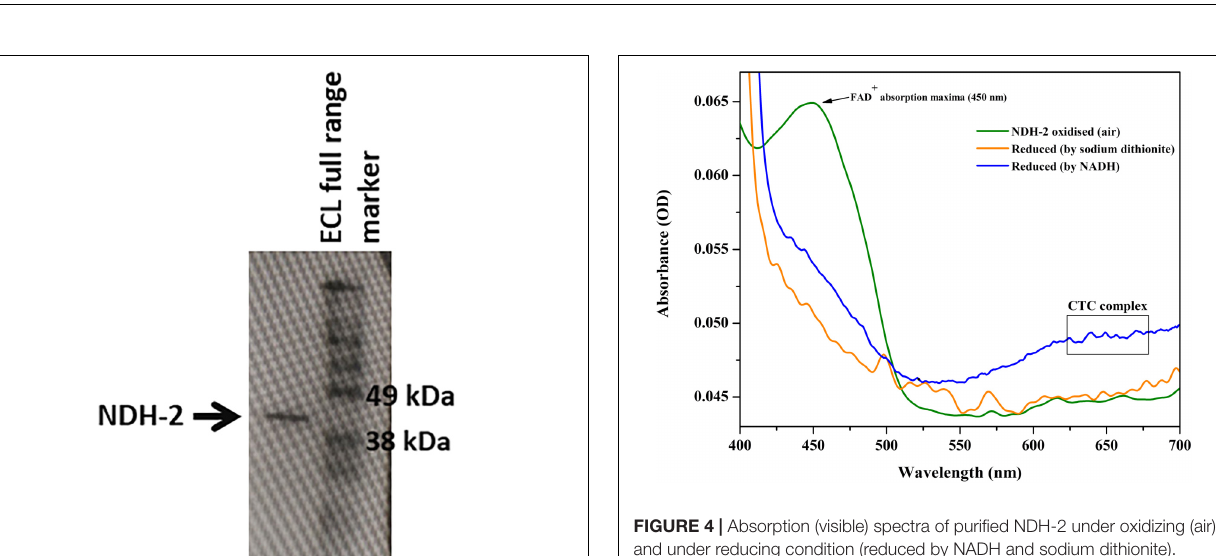
FIGURE 2 | Protein purification using his tag purification (Ni-NTA beads). Purified protein was light greenish in color emphasizing the presence of FAD + cofactor in the NDH-2.